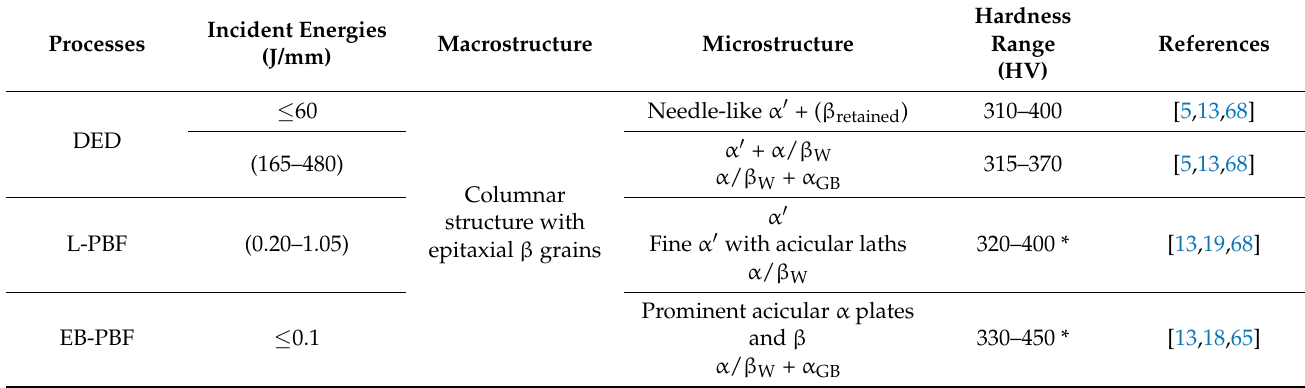
Table 2. Literature summarizing correlations between structure hardness of Ti6Al4V, for AM processes.